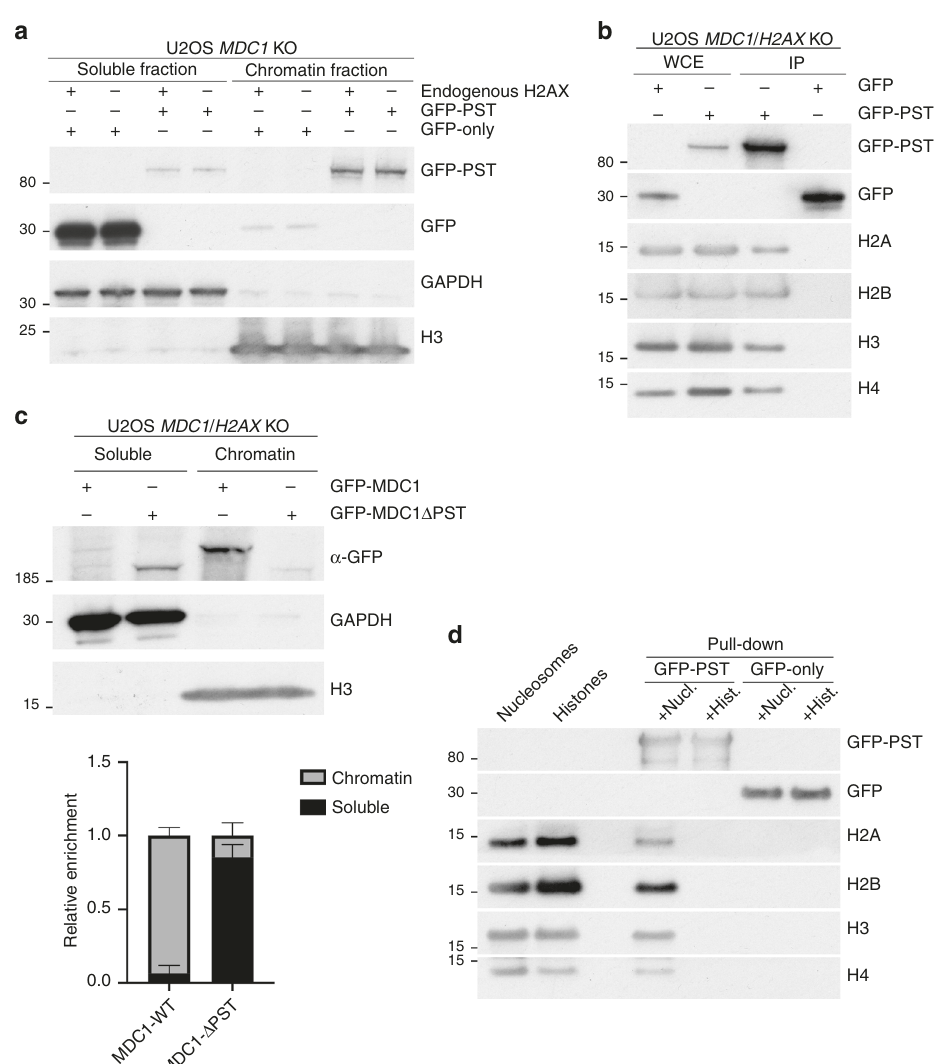
Fig. 4 MDC1 PST region binds nucleosomes and promotes DNA damage-independent association of MDC1 with chromatin. a Chromatin fractionation of U2OS MDC1 − / − and MDC1 − / − H2AX − / − cells transfected with plasmids expressing a GFP-PST construct or GFP-only. b GFP pulldowns from extracts of U2OS MDC1 − / − H2AX − / − cells expressing GFP-PST or GFP-only were analysed by western blotting using antibodies against the four core histones and GFP. c Representative image of chromatin fractionation of U2OS MDC1 − / − H2AX − / − cells transfected with plasmids expressing GFP-tagged full-length or